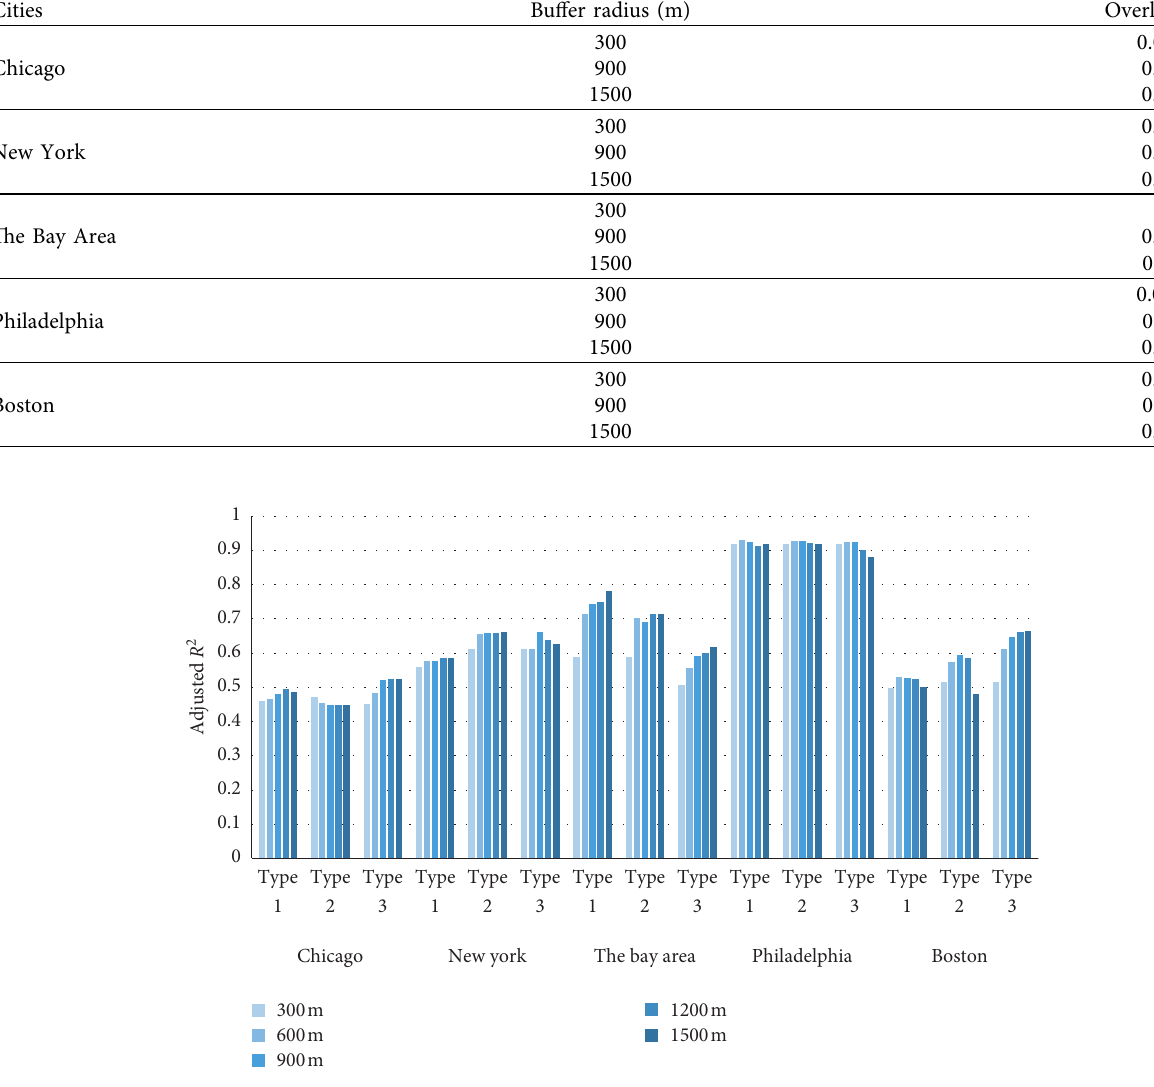
Figure 9: Linear regression result of three processing